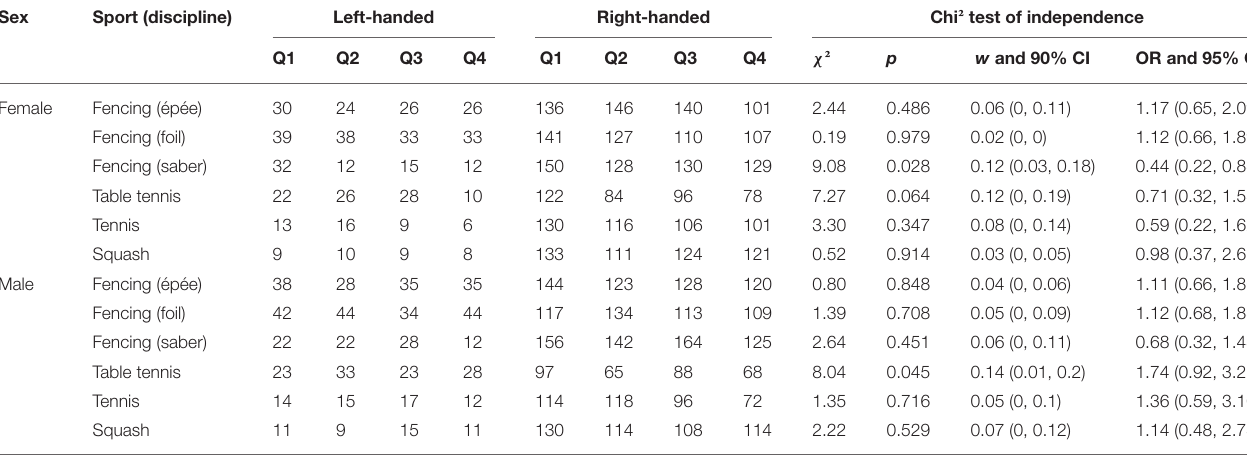
TABLE 4 | Absolute frequencies, results from chi-square tests of independence between handedness and relative age, and odds ratios in senior athletes (study 1). Sex Sport (discipline) Left-handed